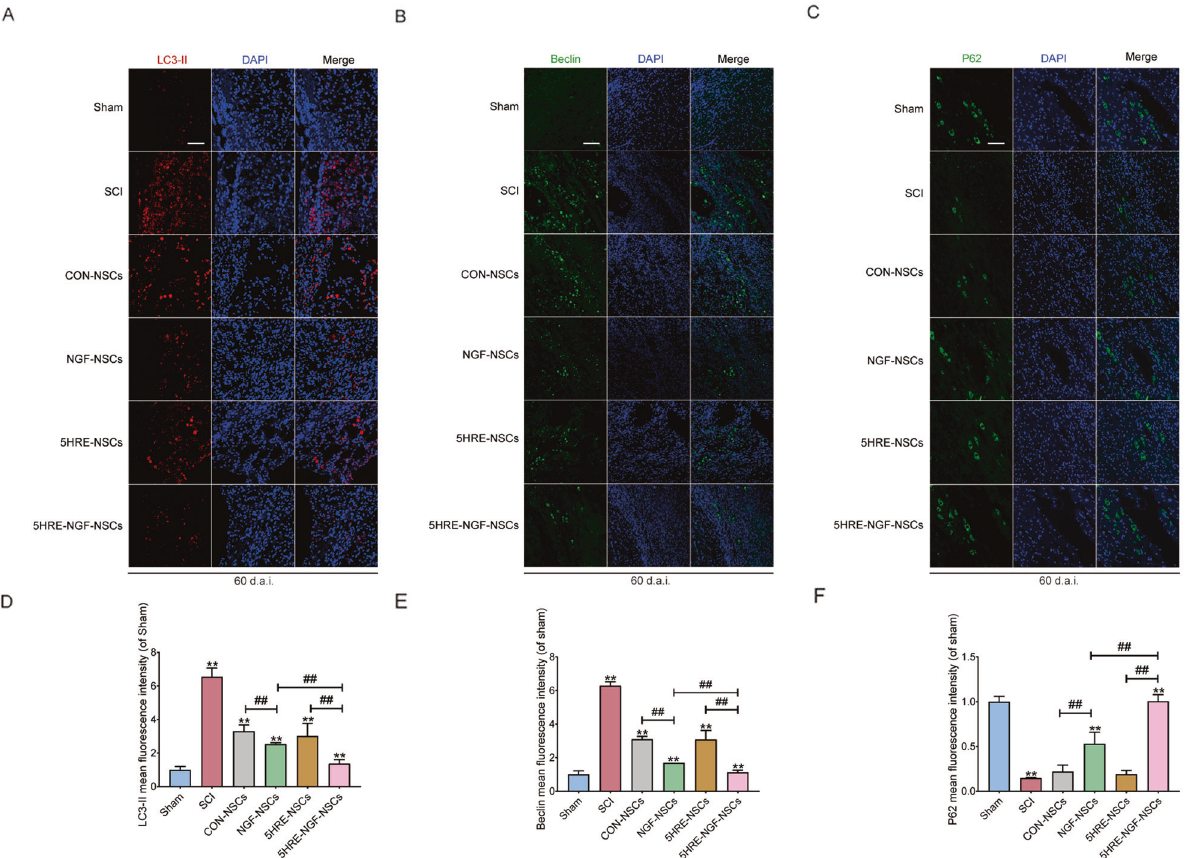
Fig. 7 The application of NSCs, NGF, and the hypoxia inhibited autophagic cell death in SCI animals. A – C LC3-II, Beclin, P62 staining of the Sham, SCI, CON-NSCs, CON-NGF-NSCs, 5HRE-NSCs, and 5HRE-NGF-NSCs group. The red dots are LC3-II + stained neurons, green dots in B signi fi es the Beclin + stained neurons and in C signi fi es the P62. The nuclei demonstrating by DAPI (blue). Magni fi cation was ×20. D – F Analysis of positive cells in immuno fl uorescence staining. ** signify P < 0.01 versus the Sham group, ## signify P < 0.01. Data are the mean values ± SD, n =